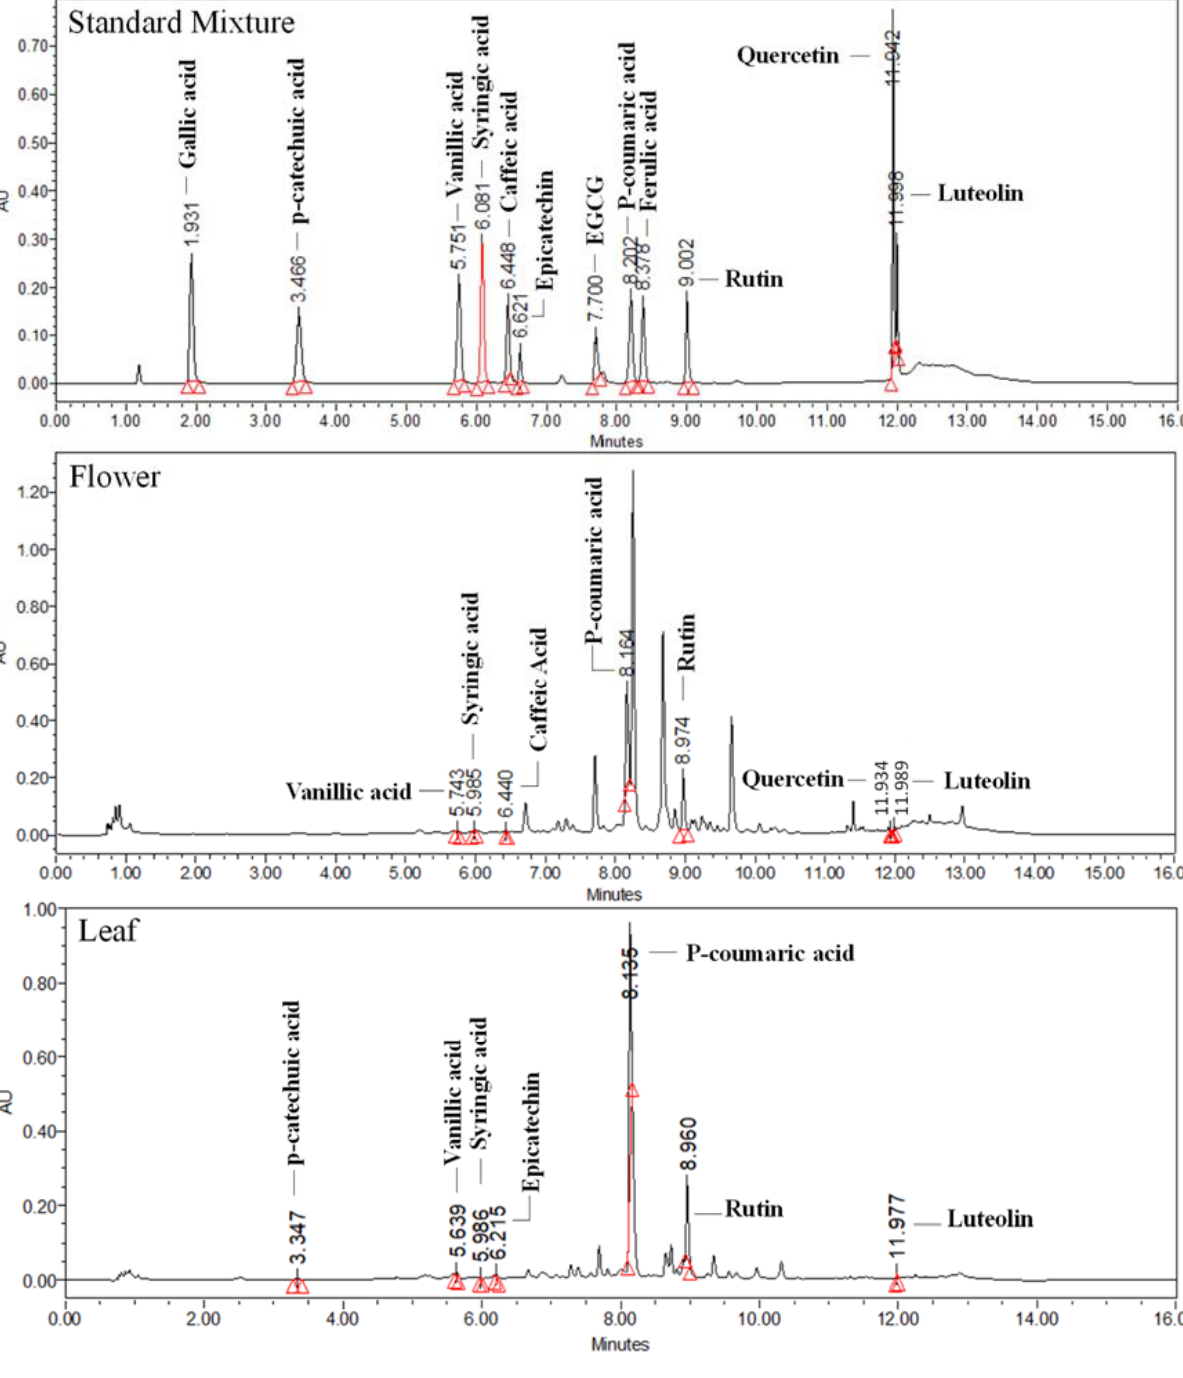
Figure 3. Representative chromatograms of reference standard mixture, flowers, and leaves samples at 270 nm.